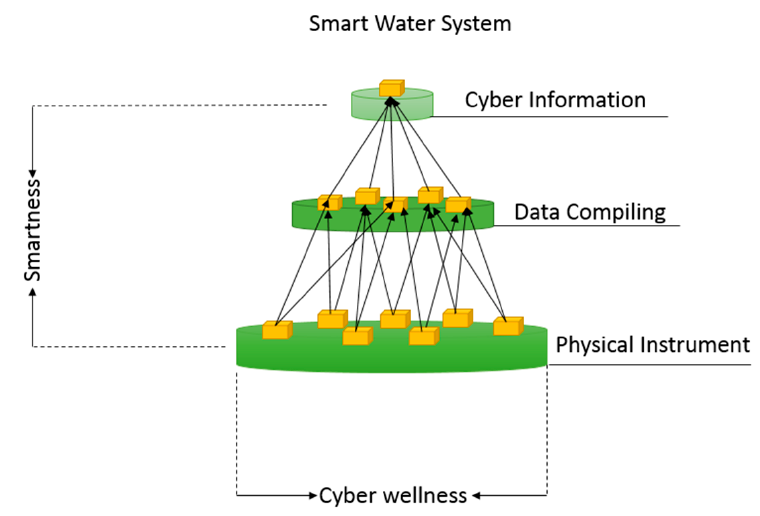
Figure 11. Illustration of a smart water system technical